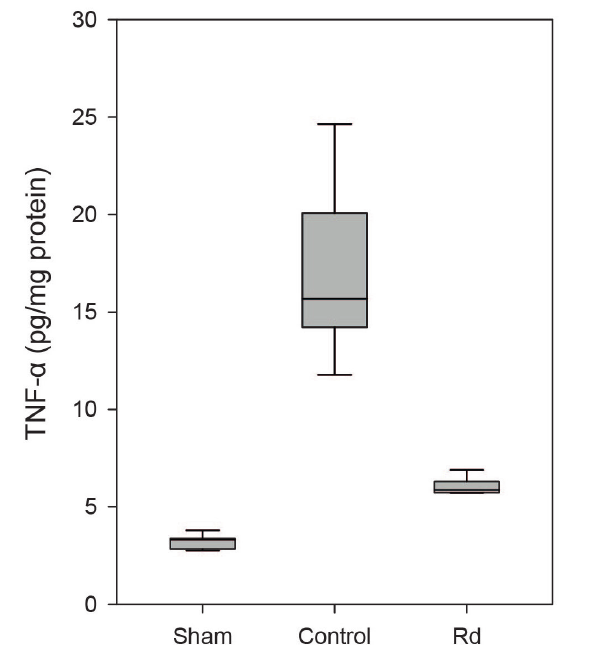
Fig. 4C - Boxplot of the levels of tumor necrosis factor-alpha (TNF-α) in each group. The level of TNF-α was significantly lower in the Rd group than in the control group (P<0.001). There was no significant difference in the levels of TNF-α between the Rd and sham groups 33 Brazilian Journal of Cardiovascular Surgery